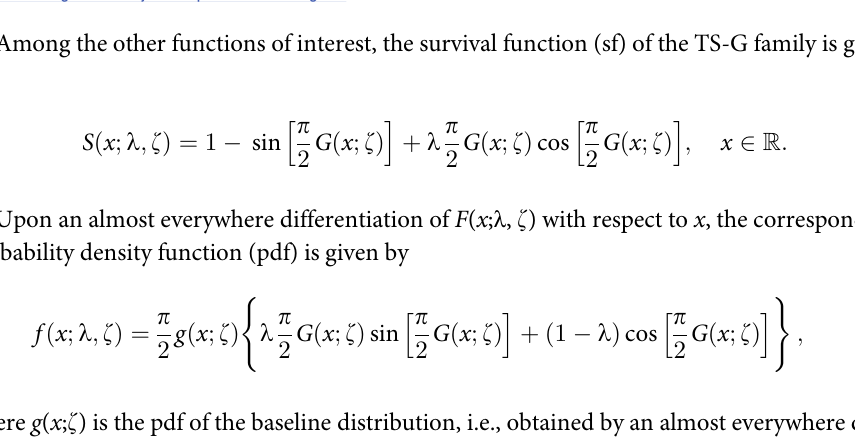
Fig 2. Plots of the function T λ ( x ) for λ 2 {0.1, 0.2, ... ,